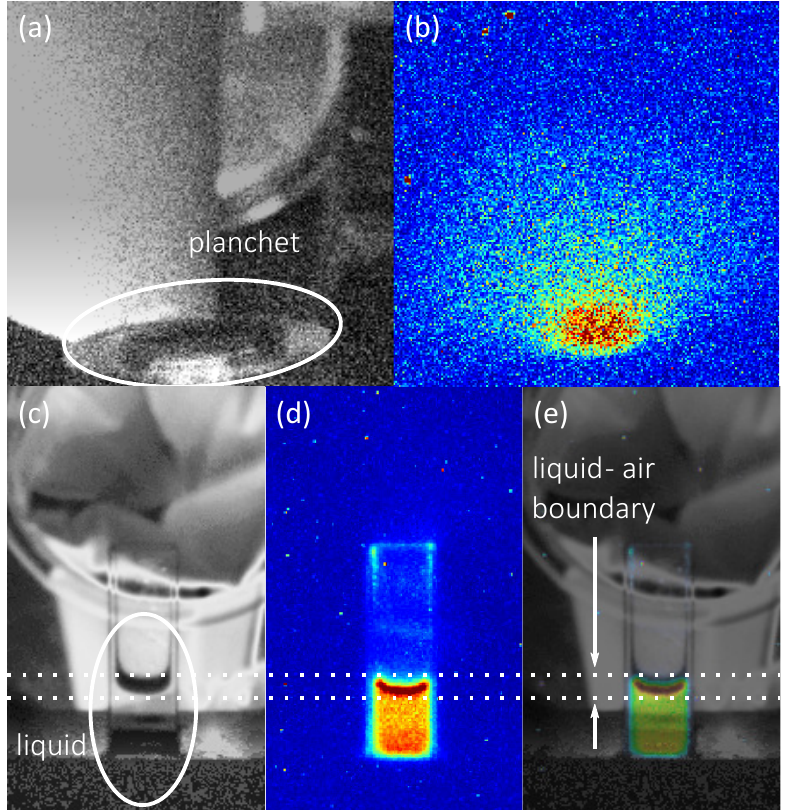
Figure 4. Images of radioluminescence and the locations where they occur. The gray scale images each show a single 0.1s capture of the samples under normal lighting conditions. The colorful images next to them show the same scenes in darkness using much longer exposure times. Dotted lines throughout the images ( c – e ) frame the area of the images where the surface of the liquid with air is displayed. The z-scale used in the images is the same as the one used in Figure 2. ( a ) Image of the Pu-239 coated planchet under normal lighting conditions. ( b ) Radioluminescence image of the Pu-239 coated planchet. ( c ) Image of the sample holder and the cuvette which resides in it taken under normal lighting conditions. The camera is slightly tilted and reveals part of the sample holder behind the cuvette. The cuvette holds the transparent liquid, the camera tilt makes it possible to see the boundary of the liquid with the air. ( d ) Radioluminescence image of the cuvette containing 750ppm of Am-241 in 3M HNO 3 solution. ( e ) Overlay of the cuvette radioluminescence image ( d ) on the image of the cuvette ( c